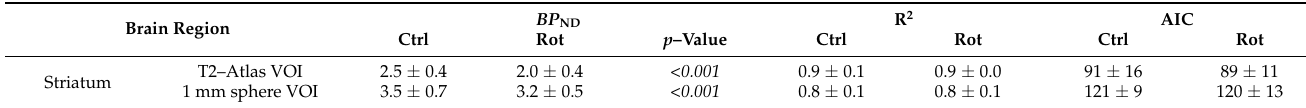
Figure 3. Mean parametric BP ND maps derived from SRTM of ( A ) control mice ( n = 7), and ( B ) rotenone––treated C57BL/6JRj mice ( n = 6). Table 5. Striatal BP ND (SRTM) calculated using the Ma–Benveniste–Mirrione–T2 Atlas or use of a 1 mm spherical VOI within the target or reference region and R 2 for control ( n = 7) and rotenone– treated ( n = 6) C57BL/6JRj